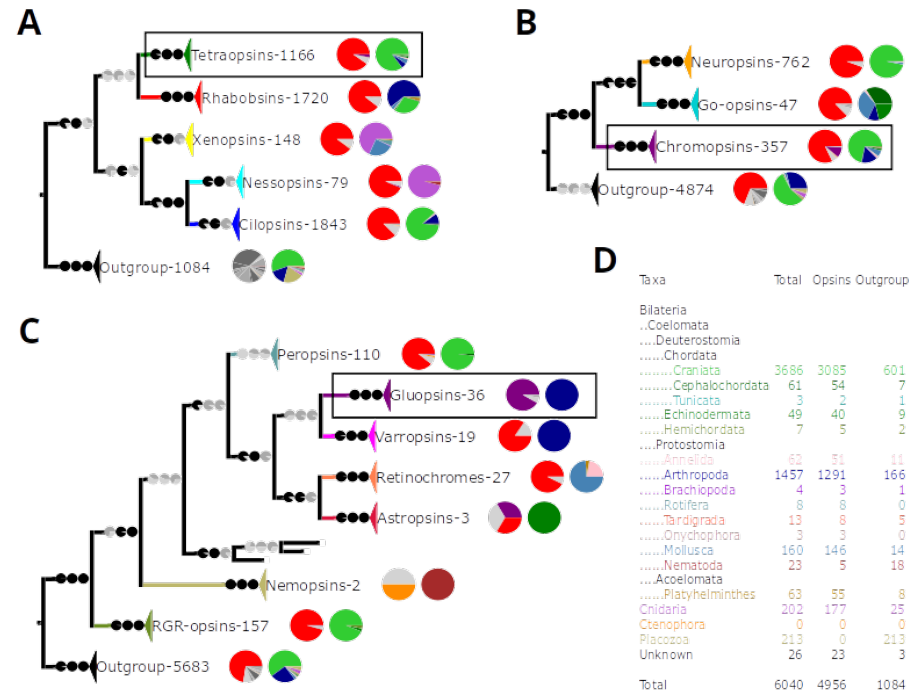
Figure 2. Phylogenetic reconstruction of the opsins. ( A ) The groups of the opsins and the outgroup are collapsed. The outgroup contains all other GPCRs. The frame highlights the tetraopsins, which are expanded in ( B ). ( B ) The groups of the tetraopsins are shown. The outgroup contains all other opsins and the non-opsin GPCRs. The frame highlights the chromopsins, which are expanded in ( C ). ( C ) The groups of the chromopsins are shown. The frame highlights the gluopsins. The outgroup contains all other opsins and the non-opsin GPCRs. ( A – C ) Next to each clade is the number of sequences within that clade shown. The first pie chart shows the percentage of a certain amino acid at lysine 296 7.43 . Red stands for lysine (K), purple stands for glutamic acid (E), the other amino acids are alternatively colored dark or mid-gray so that two adjacent amino acids have different shades of gray in the pie chart. Light gray stands for a gap at this position. This comes from sequences that are incomplete and do not contain the seventh transmembrane domain. The second pie chart gives the taxon composition for each clade, the colors correspond to the list of taxa in ( D ) The taxon composition is also given in a numerical format in Table S1. The support values are given as pie charts. They are from right to left SH-aLRT/aBayes/UFBoot. Splits are considered supported when SH- aLRT ≥ 80%, aBayes ≥ 0.95, and UFBoot ≥ 95%. If a support value is above its threshold the pie chart is black otherwise gray. ( D ) The list of higher taxa represented by the sequences. A few sequences are unidentified, since their sequence identifiers do not contain a genus name.